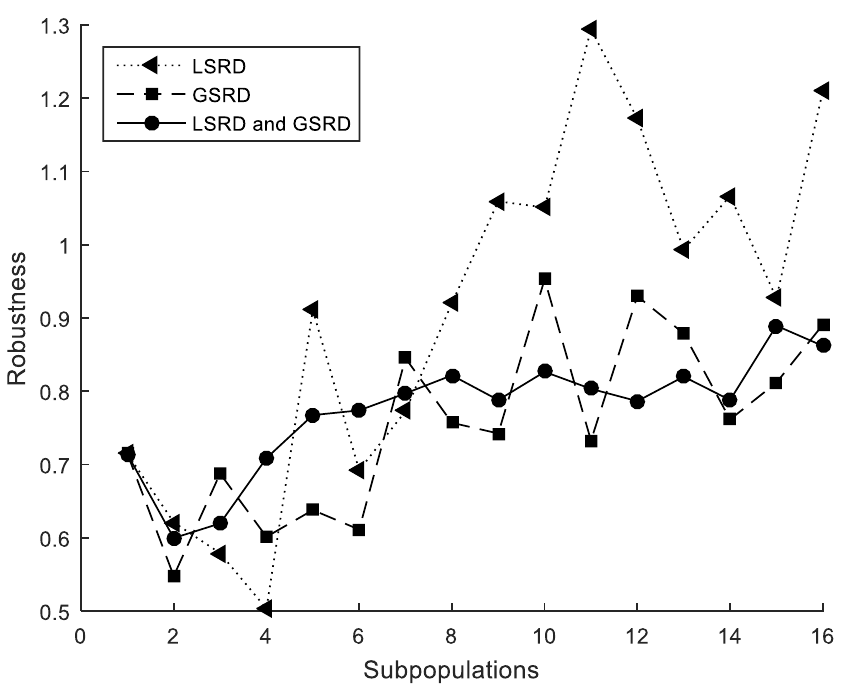
Figure 11. Cross-section under biaxial bending. Robustness.